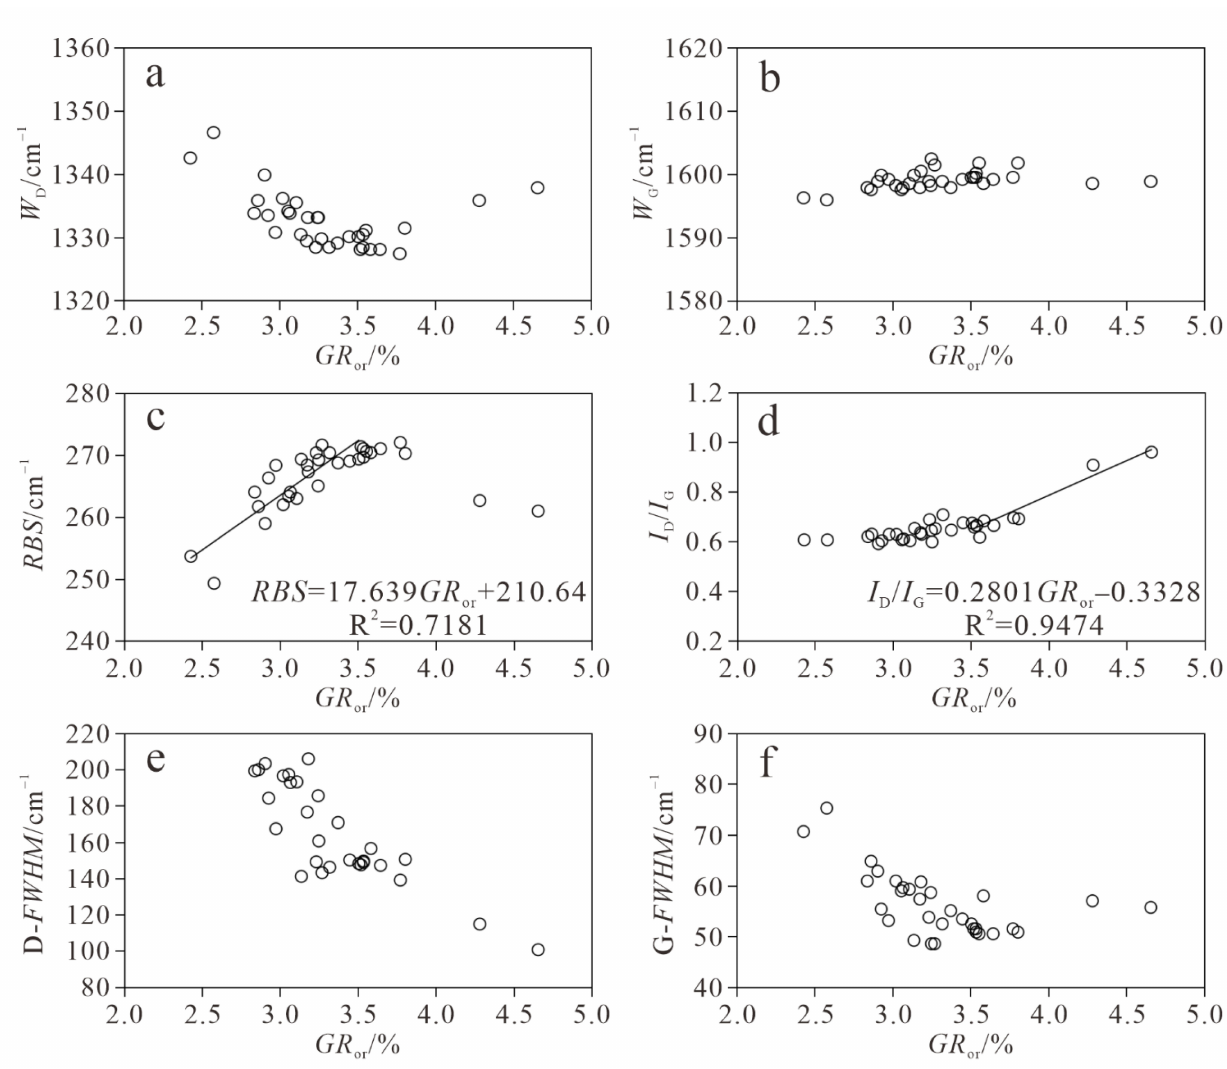
Figure 8. Plots of graptolite random reflectance versus Raman spectroscopic parameters of kerogen in the Wufeng–Longmaxi Formations from southern Sichuan Basin. ( a ) relationship between the W D and GR or ; ( b ) relationship between the W G and GR or ; ( c ) relationship between the RBS and GR or ; ( d ) relationship between the I D / I G and GR or ; ( e ) relationship between the D- FWHM and GR or ; ( f ) relationship between the G- FWHM and GR or . Circle represents the Raman spectroscopic parameter of kerogen corresponding to different GR or ; line represents the linear relationship between GR or and Raman spectroscopic parameters of